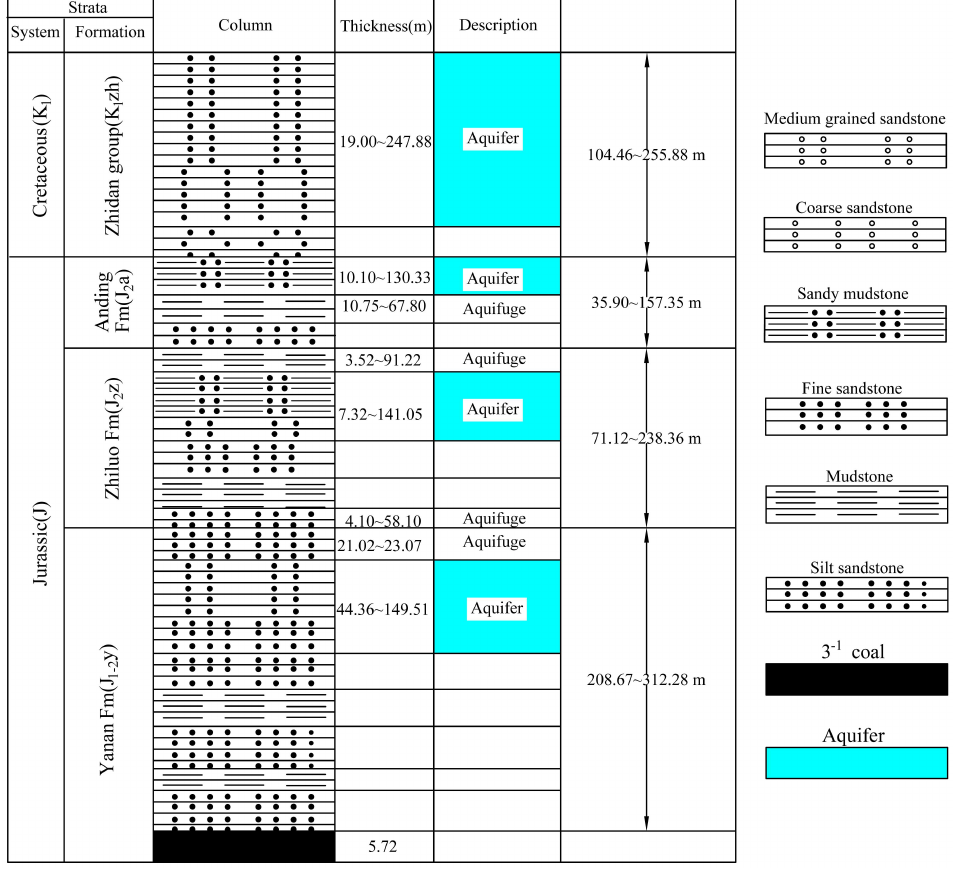
Figure 8. Development characteristics of aquifers in the roof of coal seam 3–1. Input the relevant mining conditions of panel 31110X in the Coal Mine A into the trained prediction model, and the predicted height of the water-flowing fractured zone at the mine resulted in 124.9 m, with mining fissures lead to the aquifer of Zhiluo Fm. In order to verify the performance of the model, we measured the actual height of the water-flowing fractured zone of panel